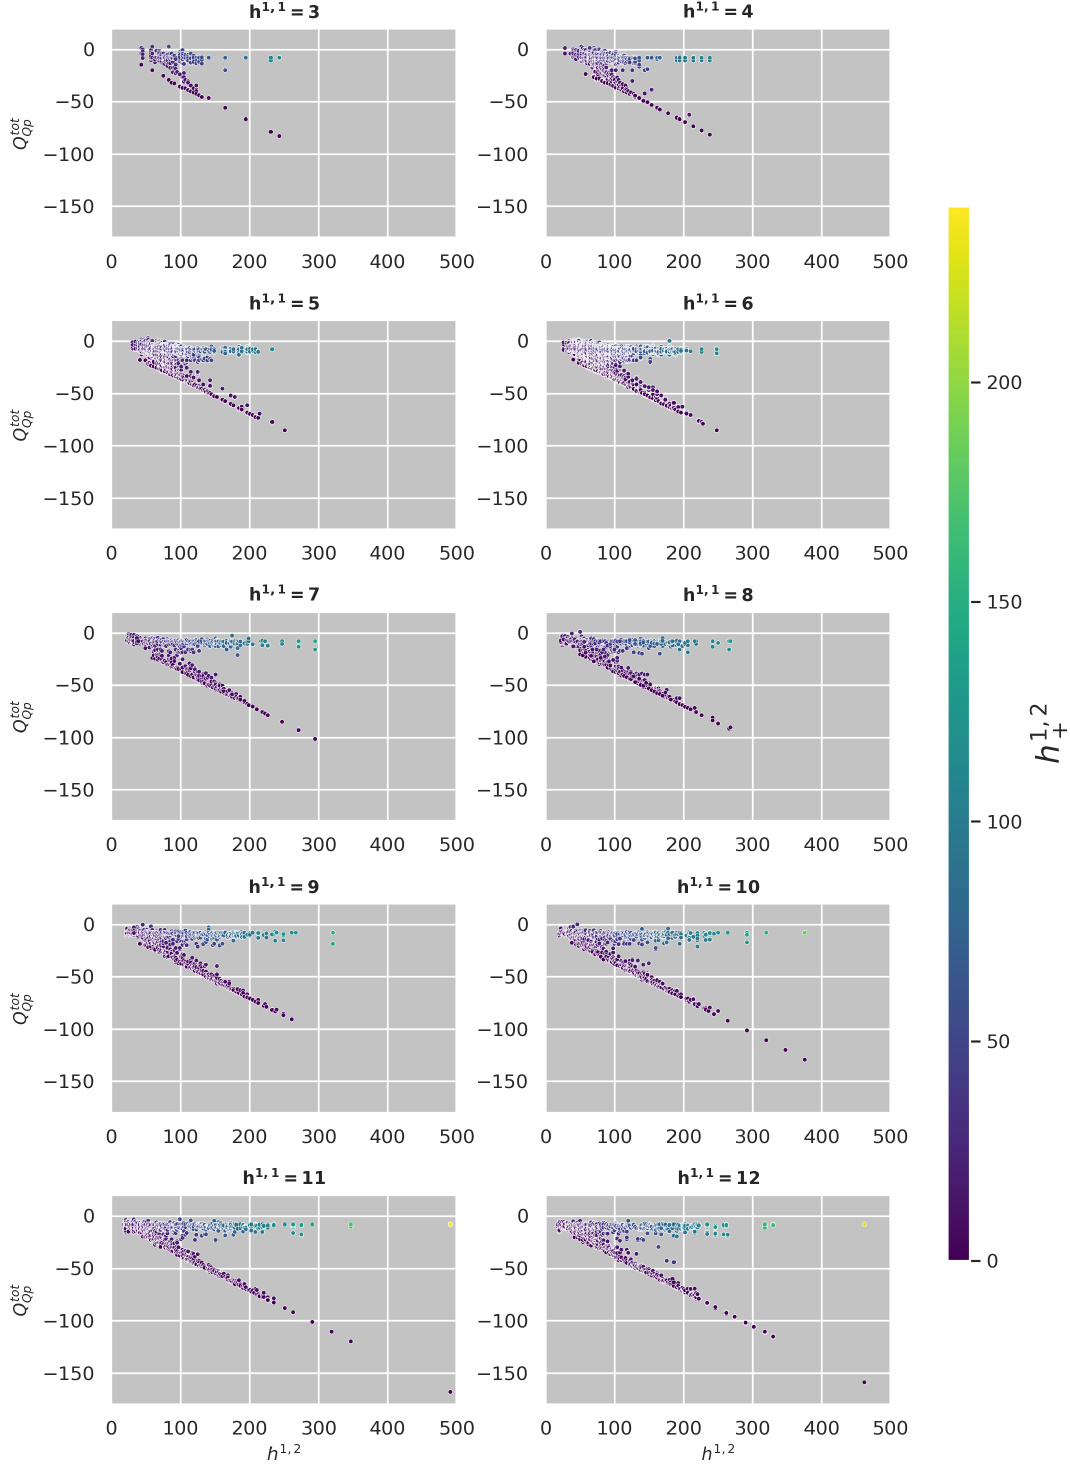
Figure 3 . Overview of the D3-charge contribution contributed by O p -planes only. For h 1 , 1 ≥ 7 , we present the data for models collected in table 3, while for h 1 , 1 ≤ 6 we use the models of table 2. The maximal absolute value for the D3-charge comes from orientifolds with Hodge